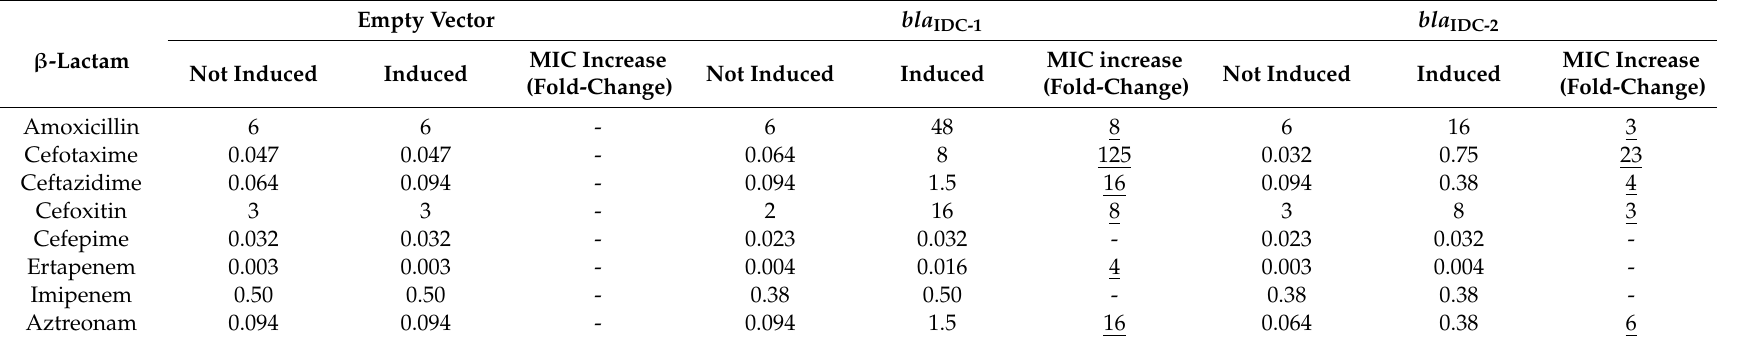
Table 2. Resistance profile of bla IDC-1 and bla IDC-2